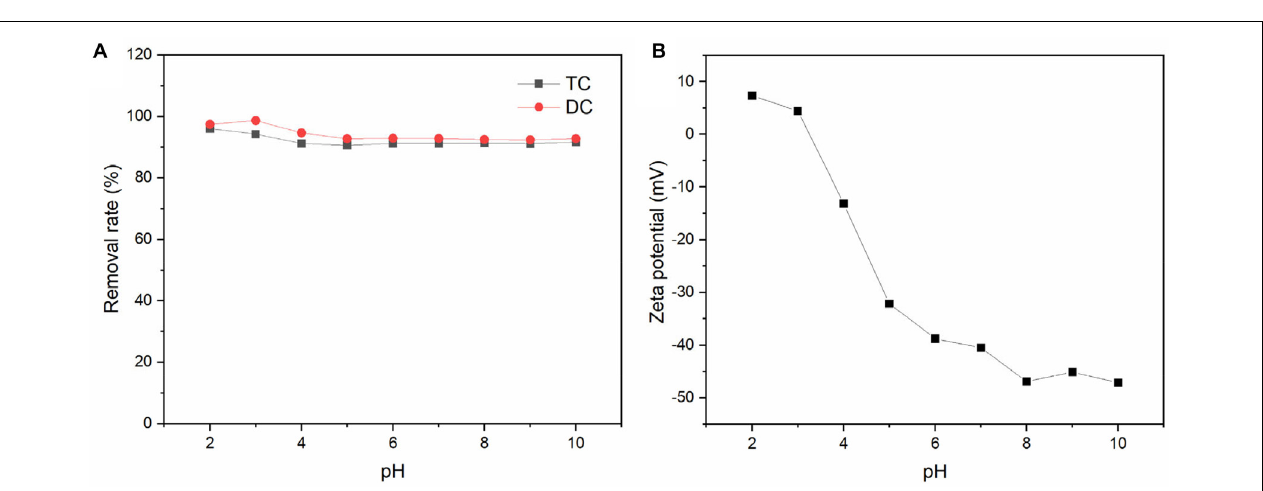
FIGURE 8 | (A) Effect of solution pH on the adsorption of TC and DC by BC/MnO 2 ; (B) the zeta potential of BC/MnO 2 at different pH.